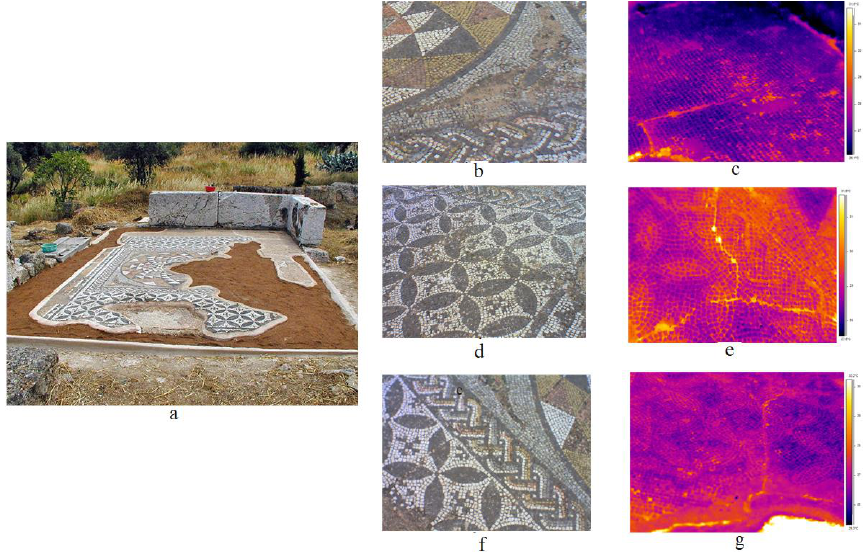
Figure 8. ( a ) Mosaic pavement from the ruins of an ancient house located at the Ancient Agora of Athens, ( b ) a region with surface cracks, ( c ) representative thermal image with visible cracks, ( d , f ) regions without surface cracks, ( e , g ) representative thermal image with invisible surface cracks. (Reprinted under the terms of the Creative Commons Attribution 3.0 license from Ref. [77]).